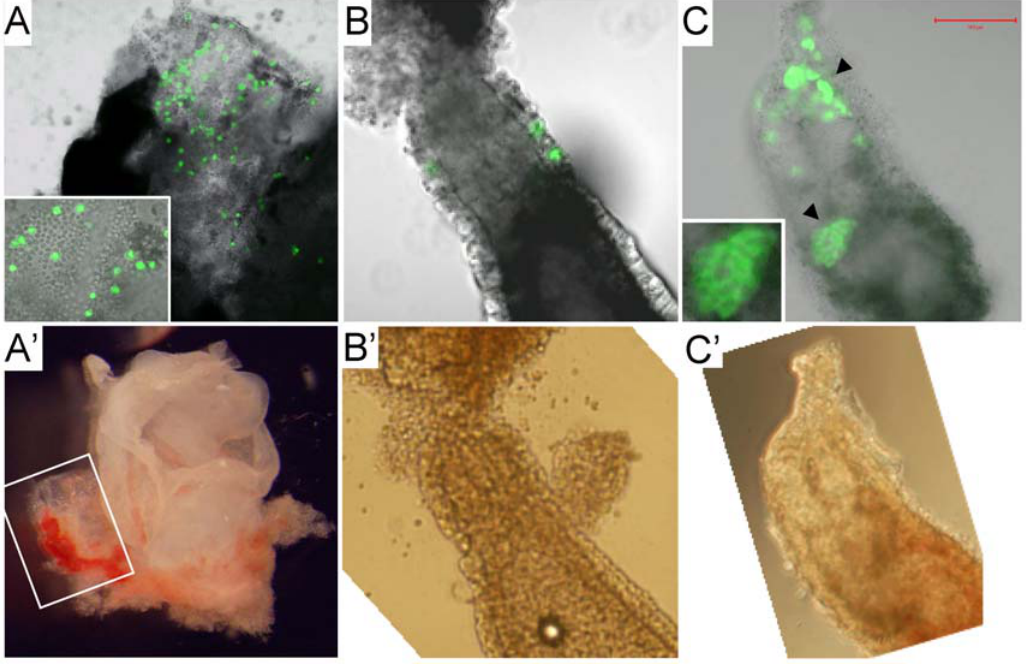
Figure 7. Contributions of rat XEN-P cell lines to postimplantation embryos. Representative fluorescence (A–C) and bright field (A’–C’) photographs demonstrating in vivo contributions of microinjected rat cells to ( A, A’ ) parietal yolk sac of an 11.5 dpc rat conceptus (inset showing magnification); ( B, B’ ) visceral endoderm of an 8.5 dpc rat conceptus; ( C, C’ ) visceral endoderm (arrowheads; one patch magnified in inset) of an , 7 dpc mouse conceptus. Pregnancy timing is distorted by the embryo manipulations and therefore only approximate.